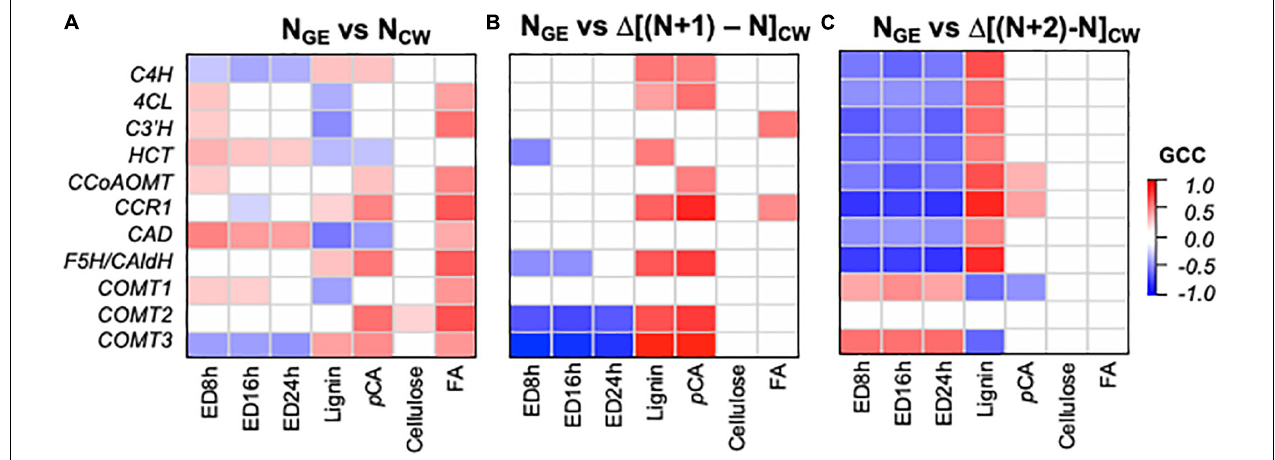
FIGURE 8 | Correlations between phenylpropanoid gene expression (GE) and the change in cell wall (CW) variables between samples reflecting different developmental times indicate that phenylpropanoid biosynthesis gene expression precedes cell wall phenylpropanoid accumulation and a change in enzymatic digestibility (ED) recalcitrance. (A) N GE vs. N CW model with gene expression and cell wall composition in the same segment. (B) N GE vs. (cid:49) [(N + 1) - N CW ] model with gene expression in a segment (N) preceding accumulation of phenylpropanoid components. (C) N GE vs. (cid:49) [(N + 2) - N CW ] model with gene expression in a segment long preceding accumulation of phenylpropanoid components. ED#h indicates the enzymatic digestibility yield after # hours of incubation. Color intensity represents magnitude of Gini correlation coefficient (GCC). Only correlations with q < 0.05 are shaded. Correlation coefficients, P -values, and q -values are available in Supplementary Table 4